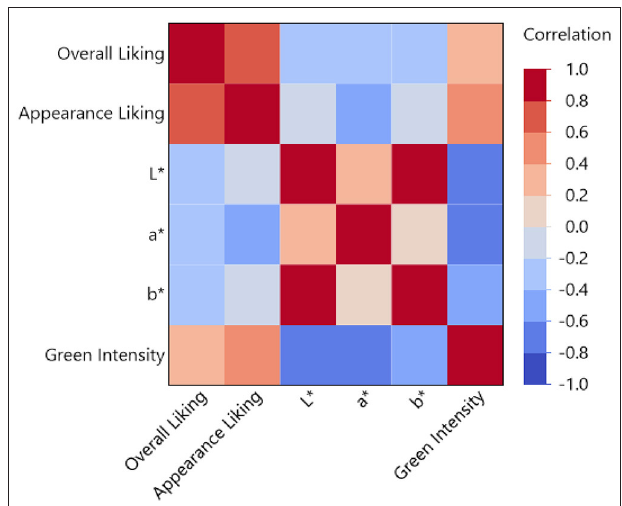
( Figure 2 ). A strong positive correlation was observed between OL and AL hedonic scores ( ρ = 0.68), as well as between the L ∗ and b ∗ color coordinates ( ρ = 0.82) ( Table 3 ).